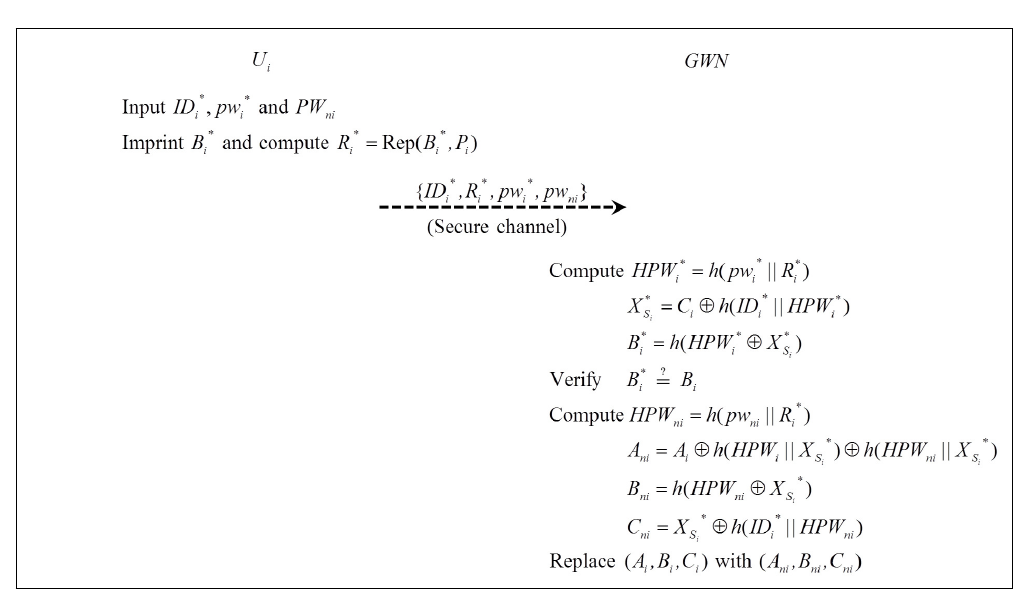
Figure 4. Password change phase.